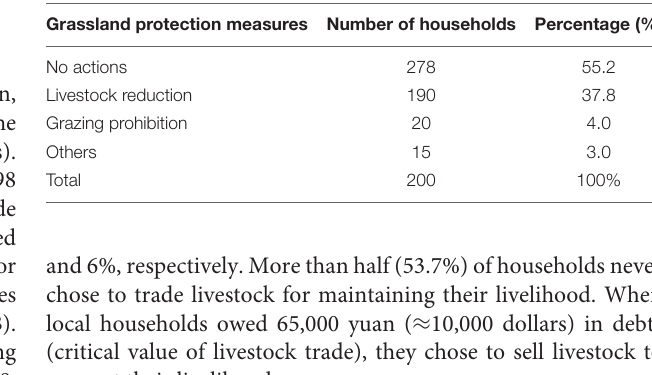
TABLE 2 | Obligation of local households on protecting alpine grassland linked to protection